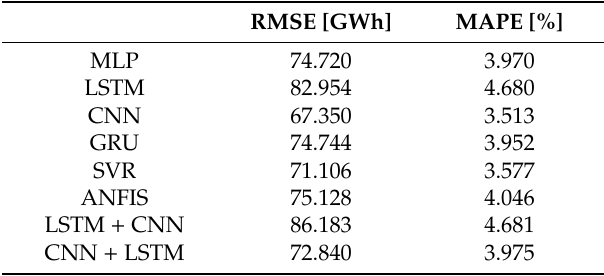
Table 11. RMSE and MAPE Results of Predicted Values for 1 Year.